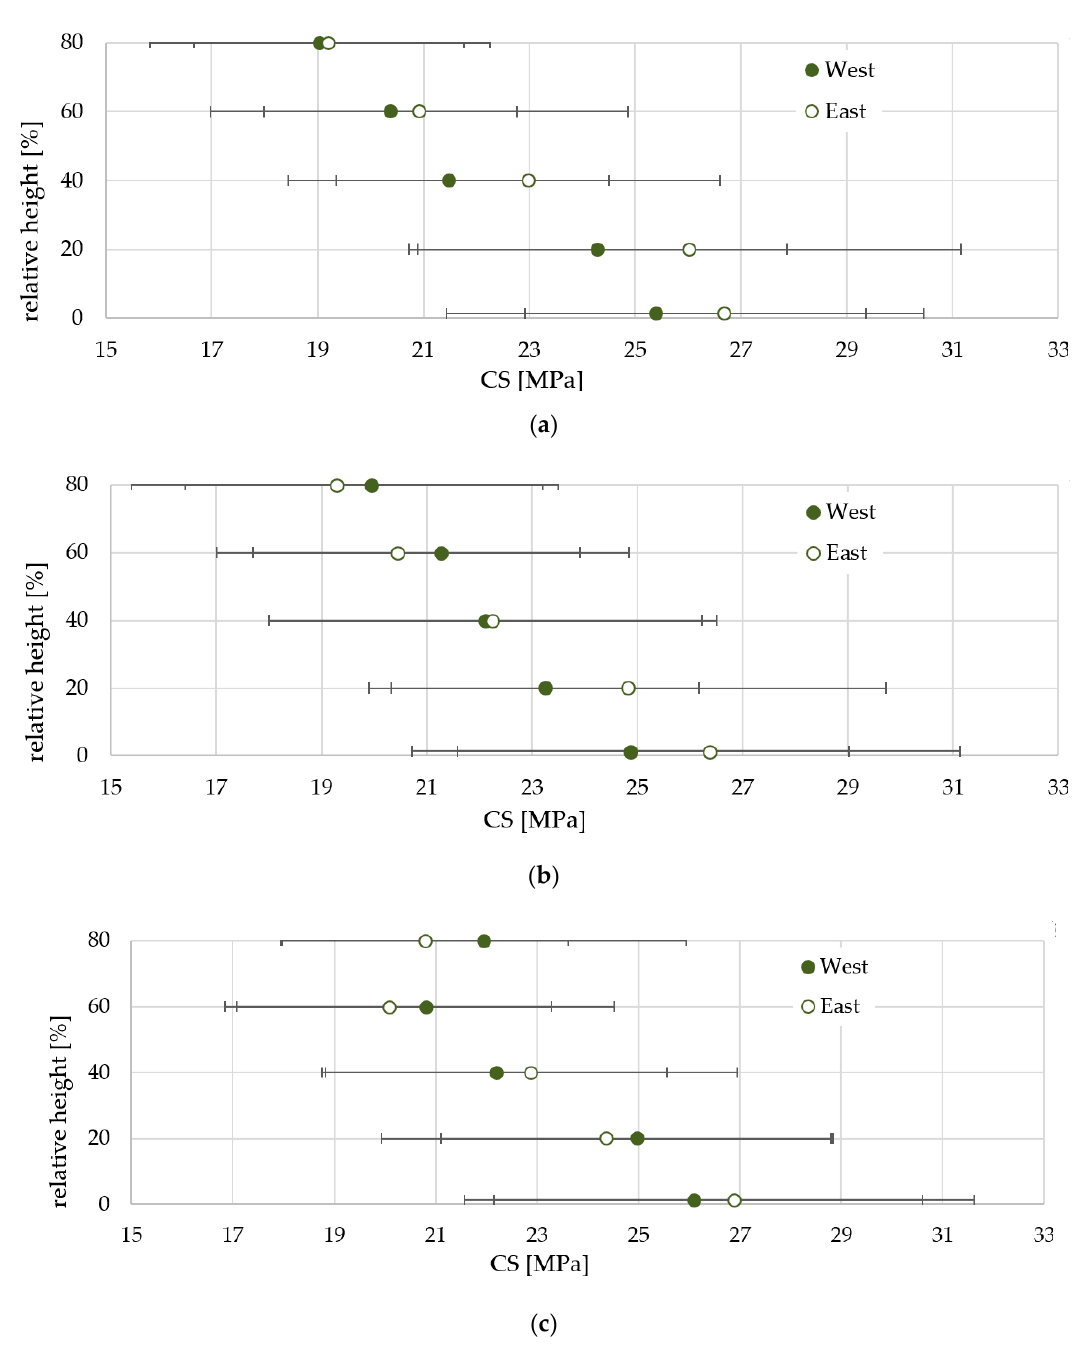
Figure 5. Variability in compressive strength longitudinal to grain (CS) along the stem (the lines represented ± standard deviation): ( a ) plot A (0–20 m); ( b ) plot B (30–50 m); ( c ) plot C (60–80 m).